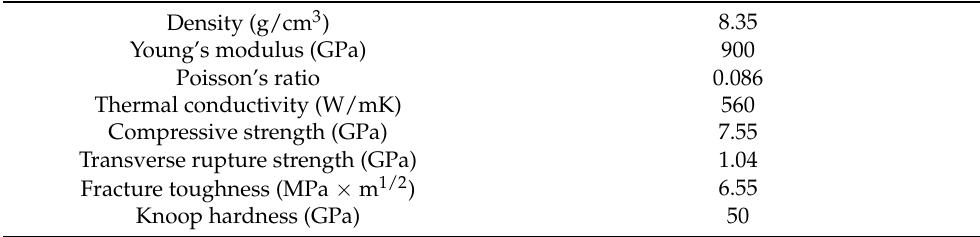
Table 1. Properties of